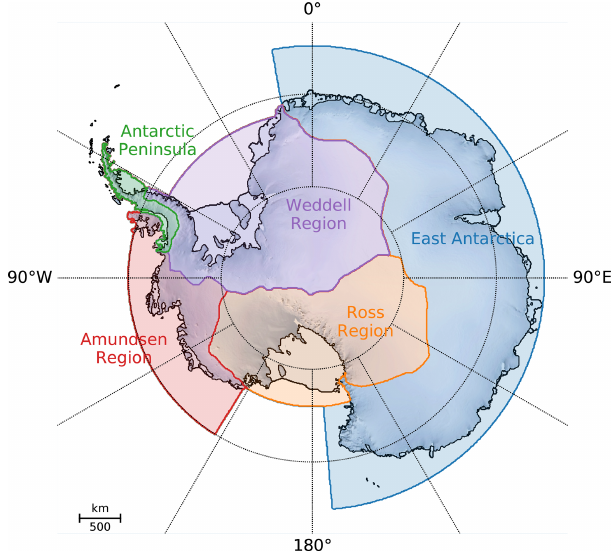
Figure 2. Oceanic regions in which the basal ice shelf melting was